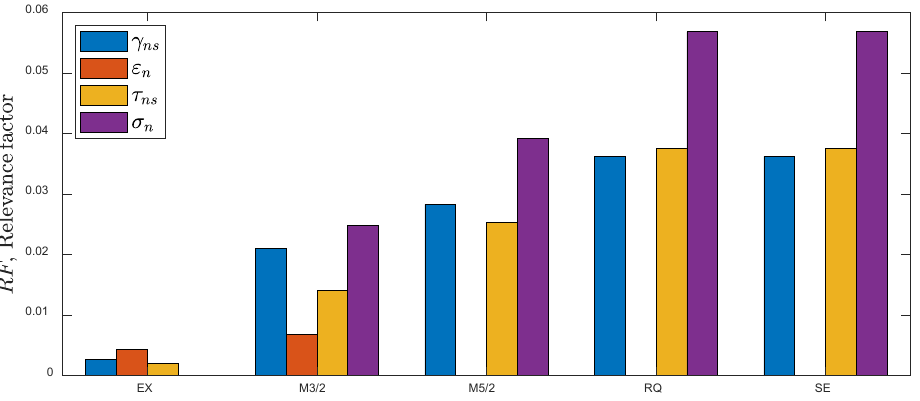
Figure 4. RFs obtained by application of different kernels for the first training dataset (uniaxial and torsion). Table 3. Hyperparameters of the covariance functions for the first training